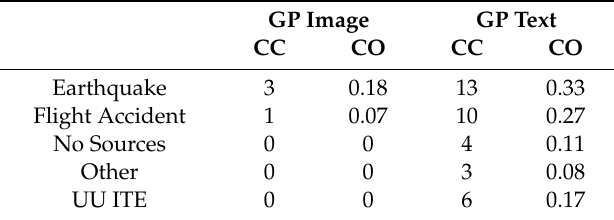
Table 23. Co-occurrence of gaze preference (GP) category and sources of anxiety.